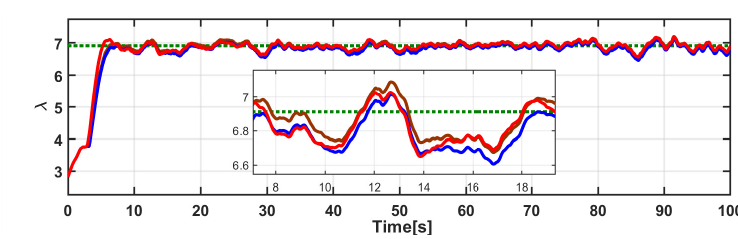
Figure 10. Lambda for region